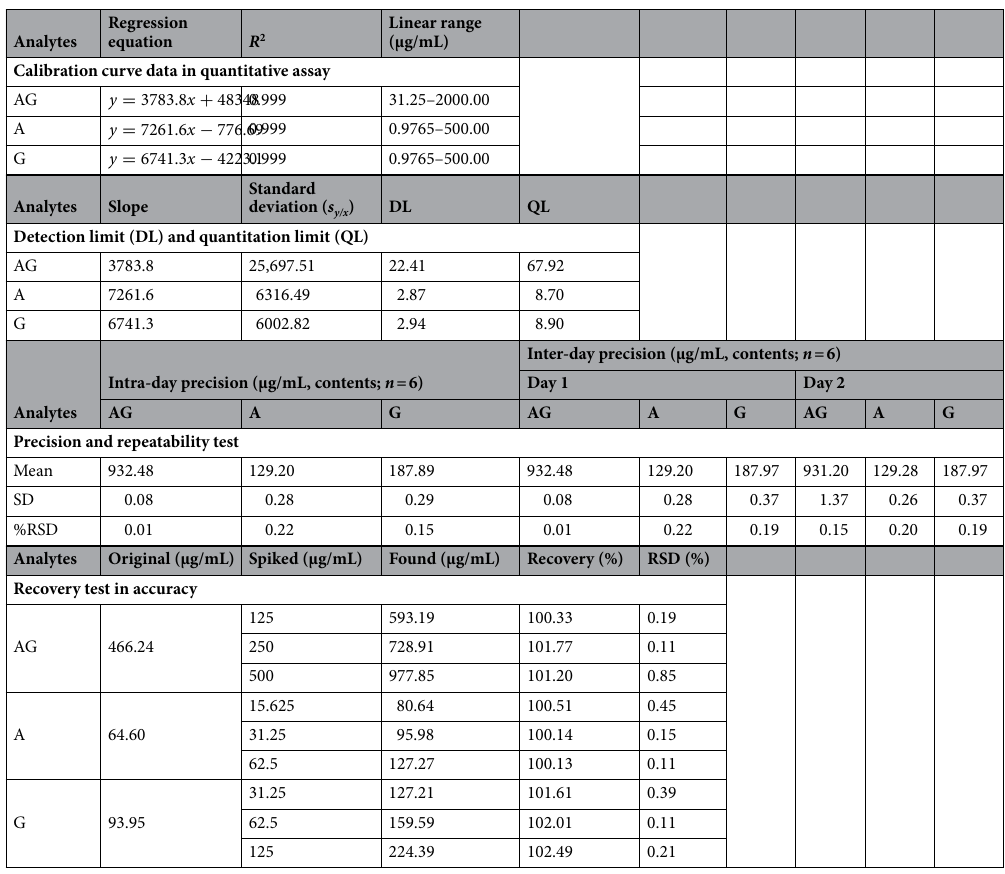
Table 7. Validation results of the method for the determination of apigenin 7- O -glucuronide, apigenin, and genkwanin in Genkwa Flos. AG apigenin 7- O -glucuronide, A apigenin, G Genkwanin, SD standard deviation, RSD relative Standard deviation, s y/x the residual standard deviation of the regression